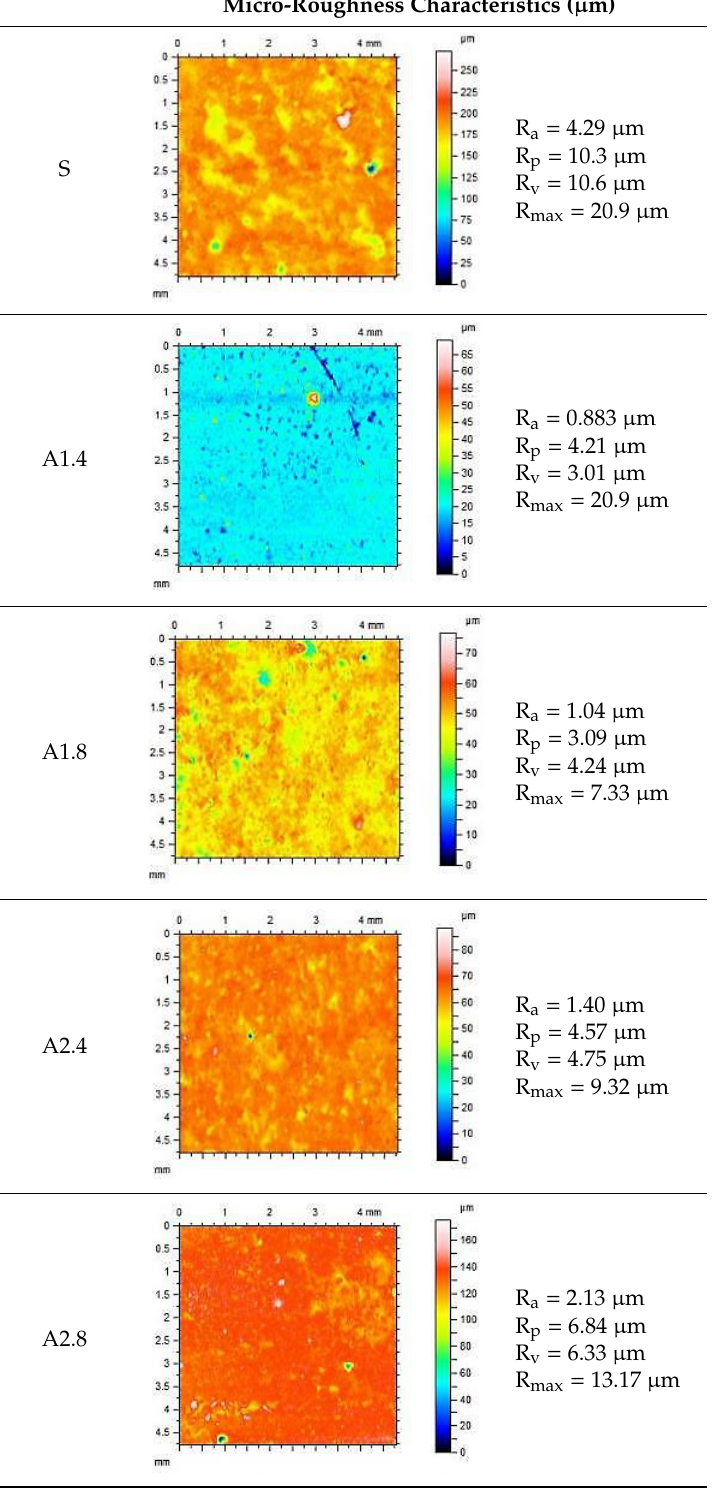
Table 8. Micro-roughness characteristics and image of the topography of mortars.